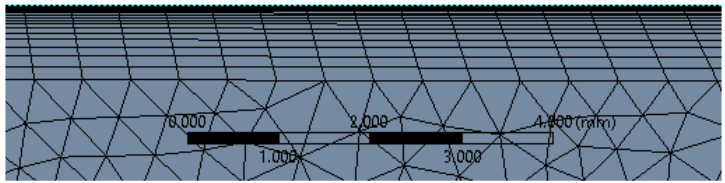
Figure 13. Boundary layer inflation zone in close proximity to the flat plate.